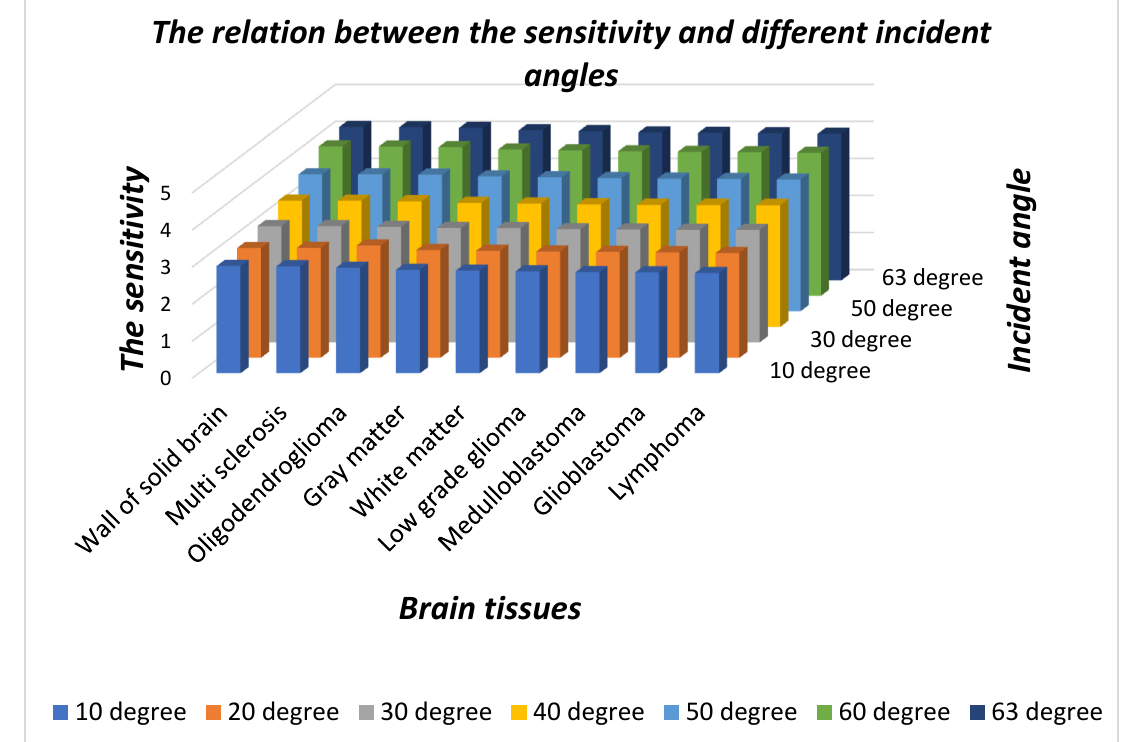
Figure 4. The 3D bar graph showing incident angle dependent sensitivity of the proposed 1D DPhC ( AB ) 2 CDC ( AB ) 2 infiltrated with nine different samples containing brain tissues with respect to CSF sample with d 4 = 15 dd , η = 0.8 at T = 4.5 K.